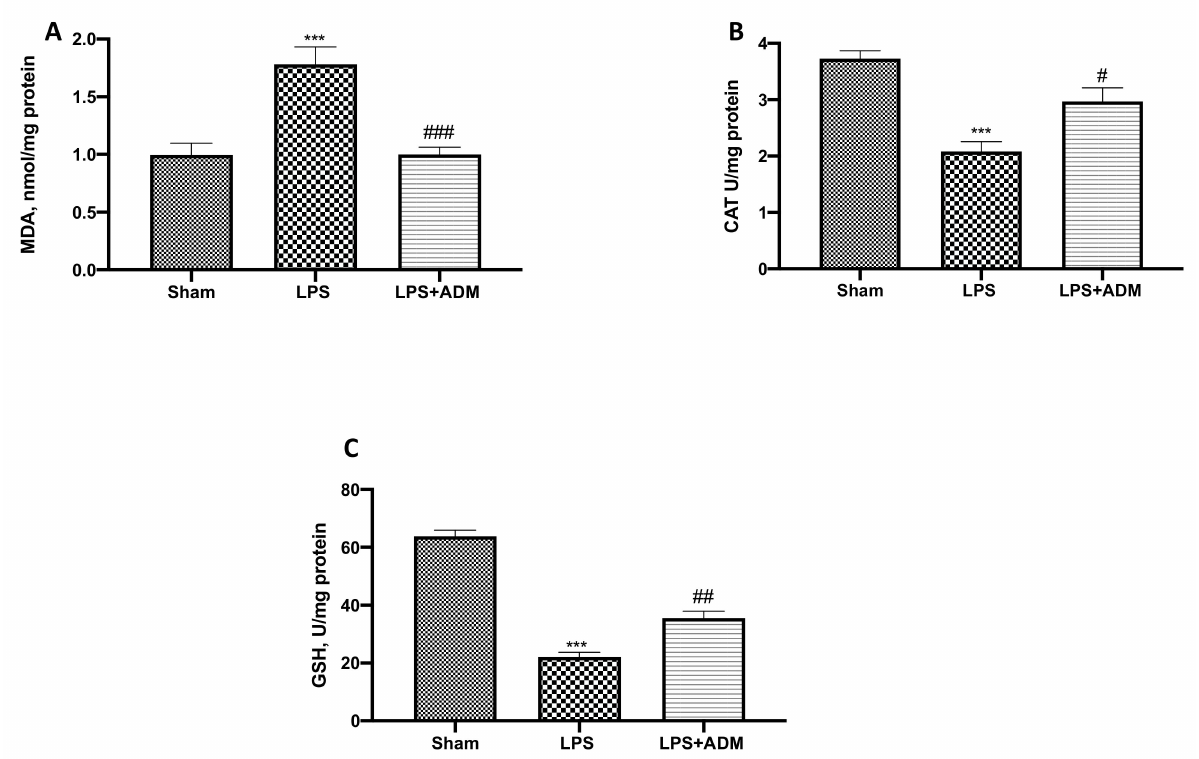
Figure 6. Markers of oxidative stress: MDA ( A ), CAT ( B ), and GSH ( C ). Data are expressed as the mean ± SEM of N = 6 mice/group. *** p < 0.001 vs. sham; # p < 0.05 vs. LPS; ## p < 0.01 vs. LPS; ### p < 0.001 vs.